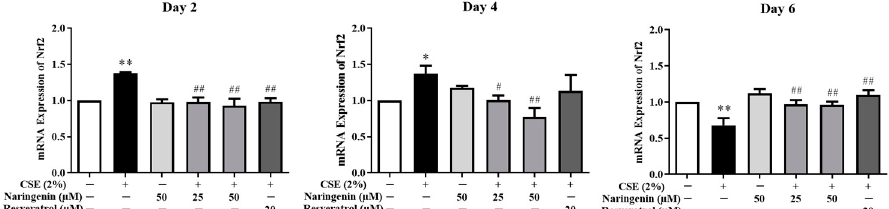
Figure 6. The e ff ect of naringenin on CSE-induced mRNA expression of Nrf2 in BEAS-2B cells. The expression value was normalized by the housekeeping gene β -actin. Data are expressed as the means ± SD of at least three independent experiments for each data point. * p < 0.05 vs. Control group, ** p < 0.01 vs. Control group; # p < 0.05 vs. CSE alone group, ## p < 0.01 vs. CSE alone group.